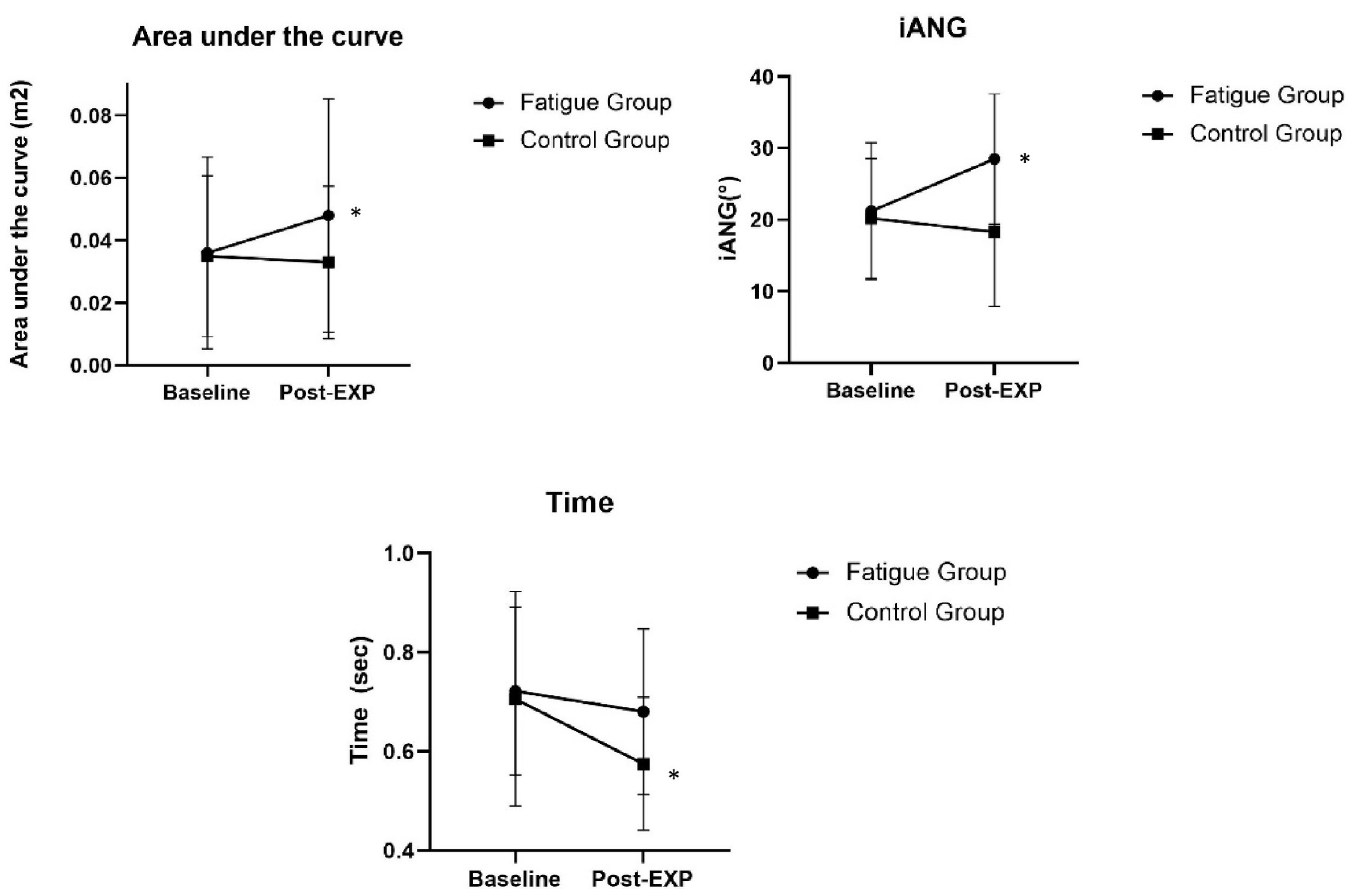
Fig 2. Spatiotemporal data. Post EXP: Post-experimental phase; Area: Area under the curve; iANG: Initial angle; Time: Time to reach the peak. Data are presented as mean values for the four targets (SD).